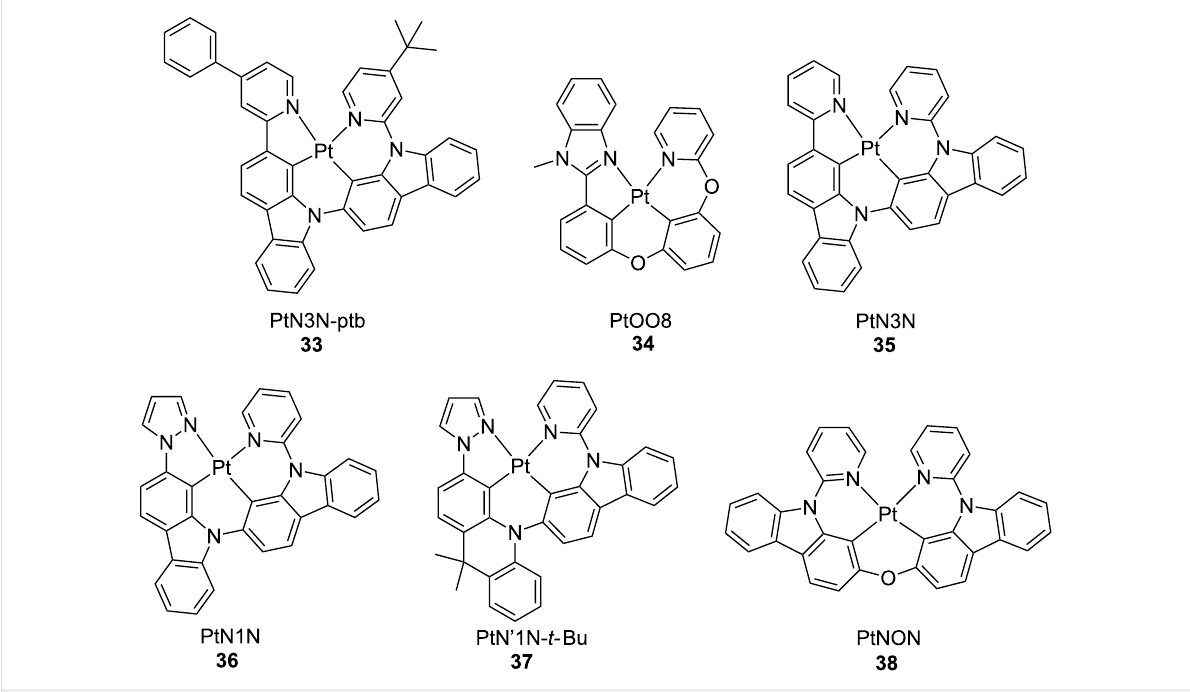
Figure 17: Chemical structure of the tetradentate Pt complexes 33 – 38 based on N^C^C^N-type of ligands [80-84].